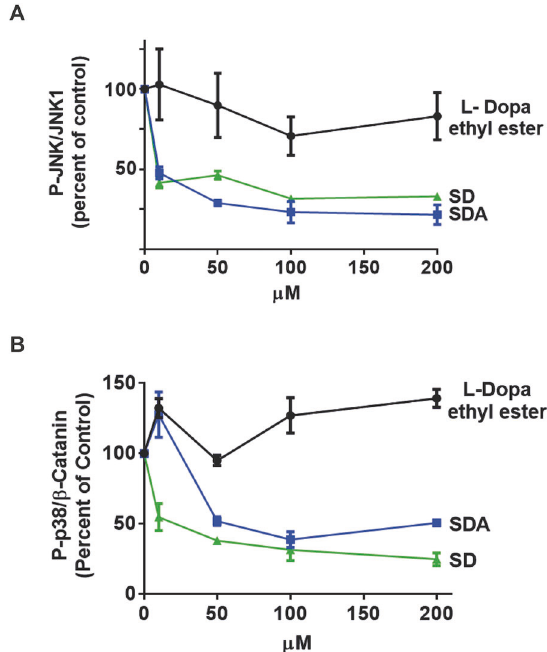
Fig. 6 SD, SDA but not LDEE, reverse Auf-induced JNK and p38 MAPK phosphorylation. A concentration-dependent reduction in Auf-induced phosphorylation of A JNK and B p38 MAPK by SD, SDA, and LDEE (see legend and blots in Fig. S11). The ratios of phospho- JNK/JNK1 and phospho-p38 MAPK / β -catenin were calculated as percentage of control based on two independent experiments (±SEM) for each of the